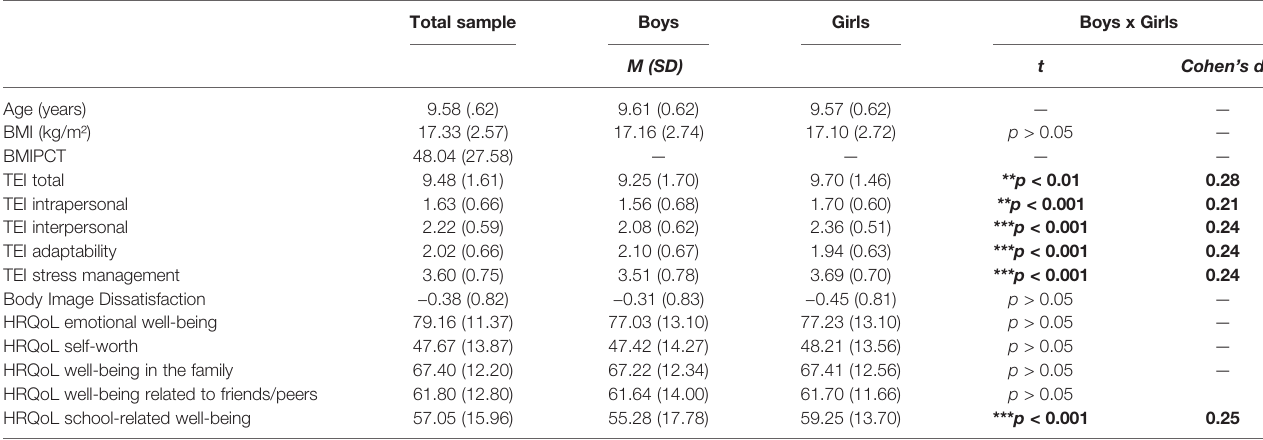
TABLE 1 | Sample characteristics and independent samples t-test regarding all variables of interest (total sample: N = 991, respectively N = 787 for parental reports of HRQoL). Total